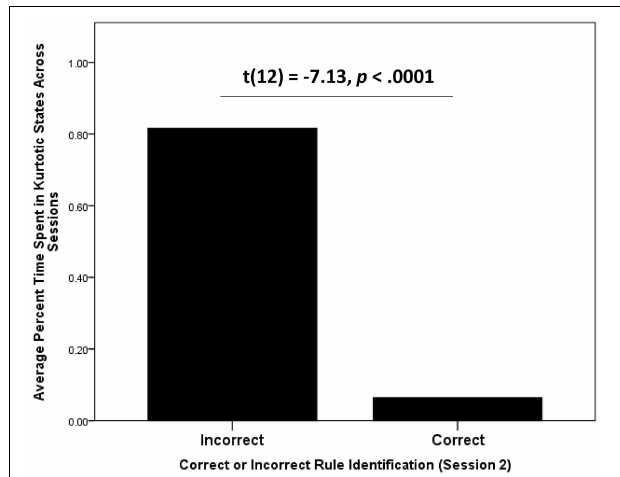
FIGURE 9 | Average time spent in kurtotic states by participants who were identified by blind raters as having correctly described the rule governing how to accumulate points in Wiggle. Participants who correctly reported the rule after both sessions were significantly less likely to spent time in kurtotic BP-HMM